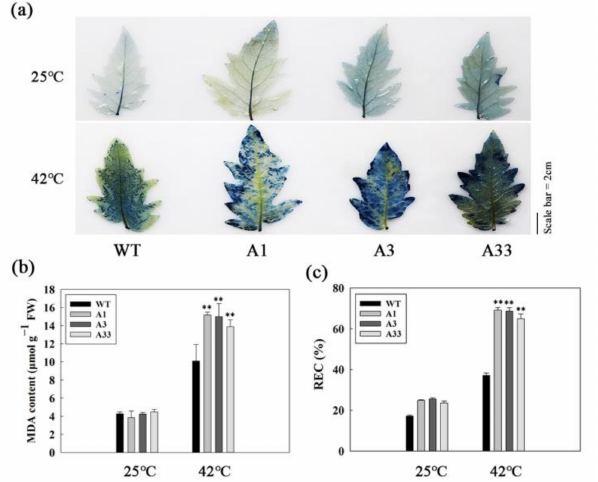
Figure 5. The integrity of biological membrane of WT and AS lines. ( a ) Trypan blue staining. ( b ) Content of MDA. ( c ) Ion leakage. ** ( p < 0.01) indicate significant differences relative to the WT